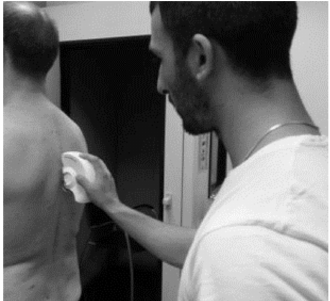
Figure 1. Thoracic and lumbar angles assessment with SpinalMouse ® .